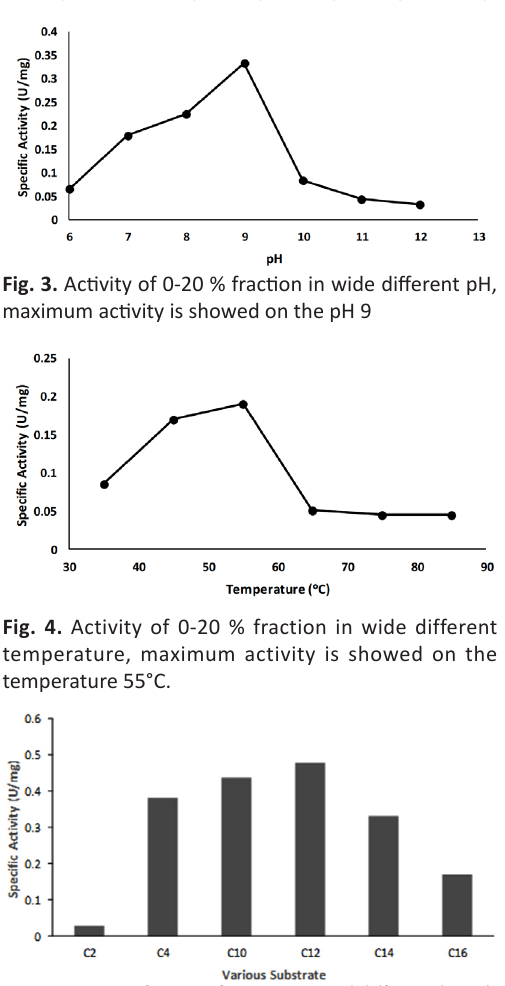
Fig. 2 . SDS-PAGE Electrophoregram of partial purified lipase. (A) SDS-PAGE Lane 1, protein marker; lane 2, crude extract; lane 3, 0-20%; lane 4, 20-40%; lane 5, 40-60% acetone fraction (B) zymography of partial purified enzyme. Lane 1, crude extract; lane 2, 0-20 %; lane 3, 20-40 %; lane 4, 40-60% acetone fraction.